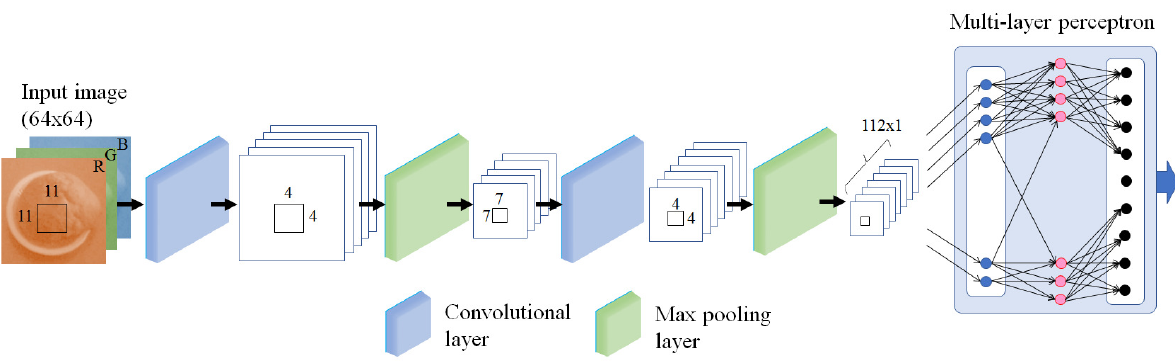
Figure 7. Architecture of the proposed CNN for the classification of food